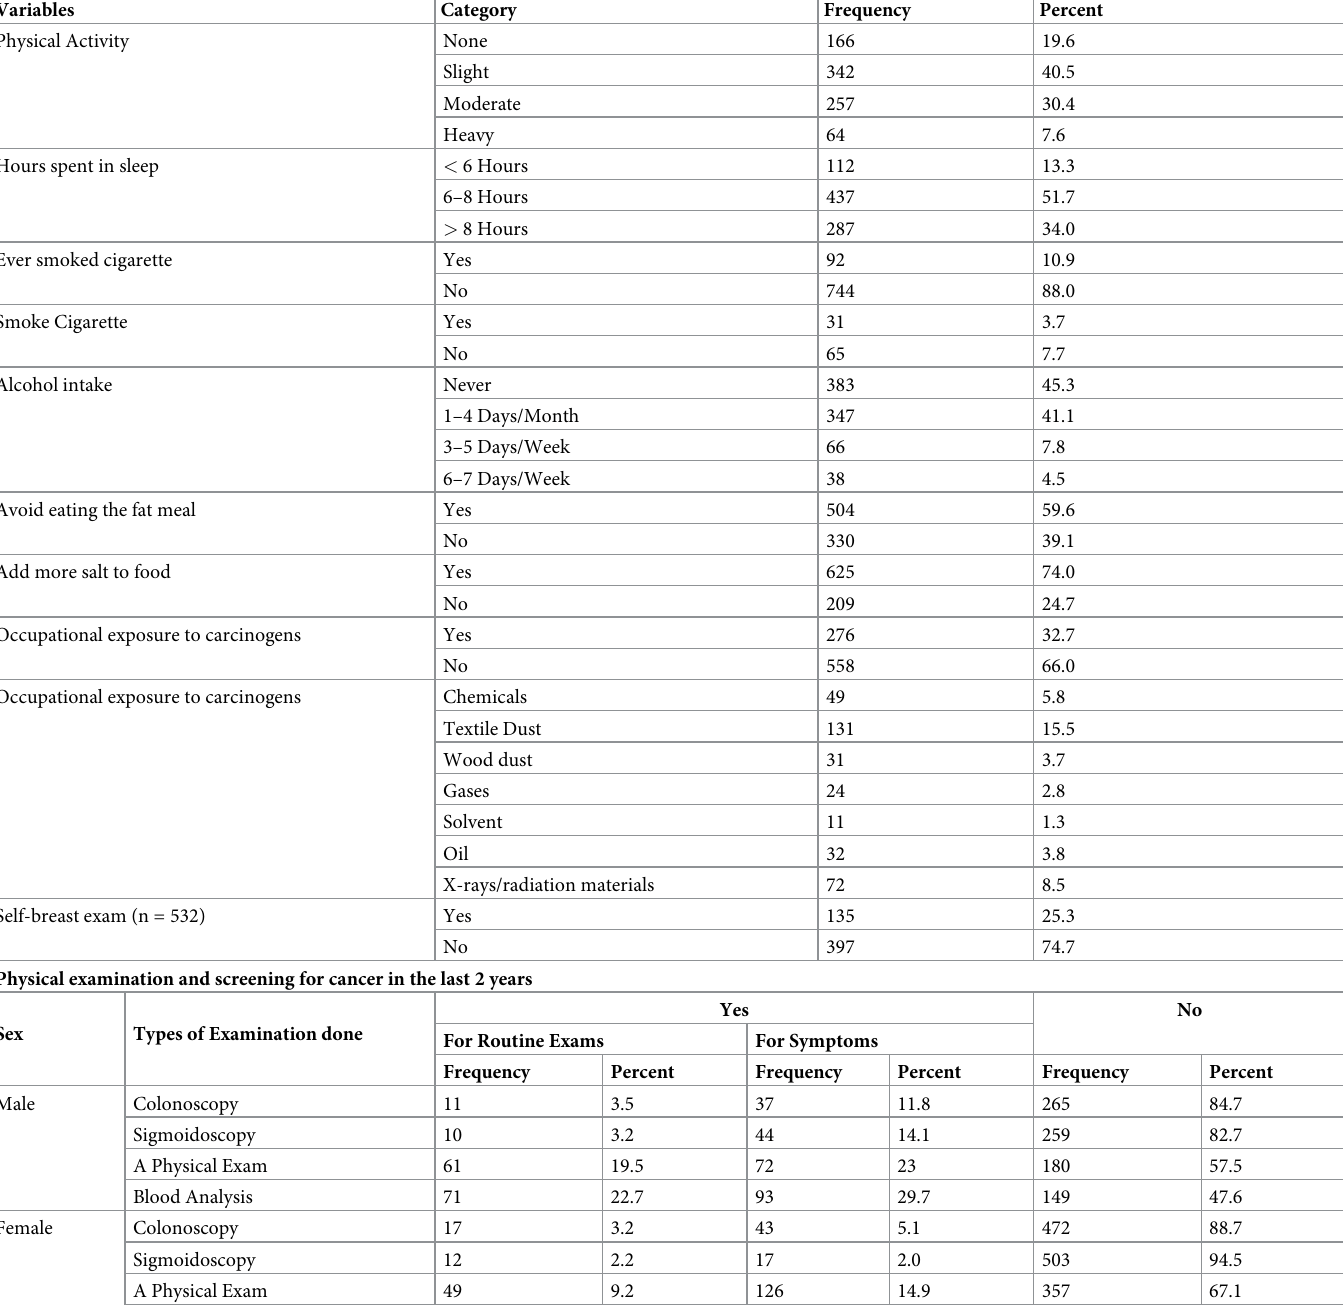
Table 4. Cancer preventive practices of the respondents, Bahir Dar city residents, North West Ethiopia 2019, (n = 845).